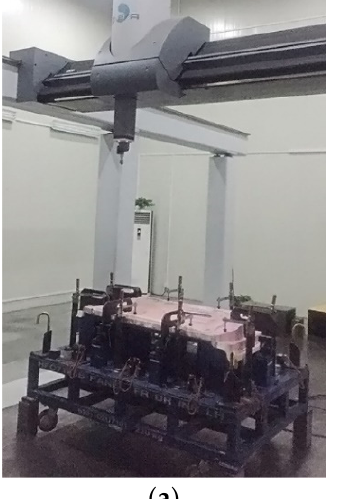
Figure 4. Range of hydraulic pressure loading path.